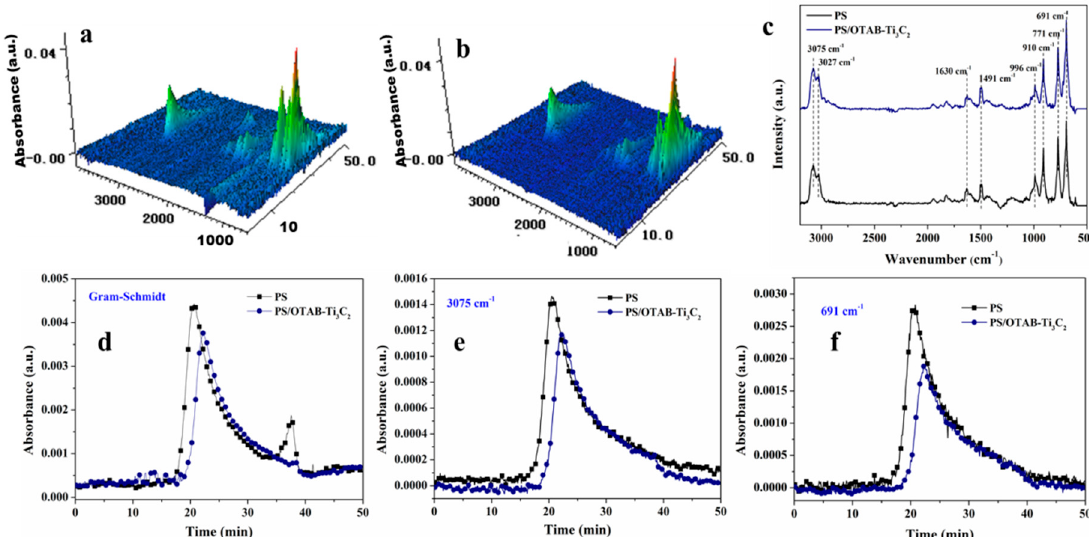
Figure 6. 3D TG-FTIR spectra of ( a ) PS and ( b ) PS/OTAB-Ti 3 C 2 ; ( c ) FTIR spectra of volatile products of PS and PS/OTAB-Ti 3 C 2 at maximum degradation rate; Gram–Schmidt curves of total absorbance ( d ), hydrocarbon compounds ( e ) and aliphatic compounds ( f ).